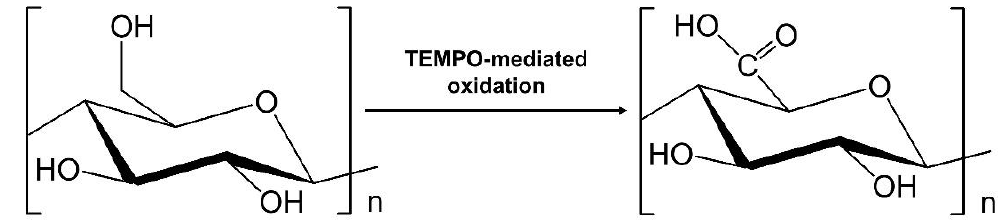
Figure 2. Oxidation of C6 hydroxyl group of cellulose in a TEMPO-system.